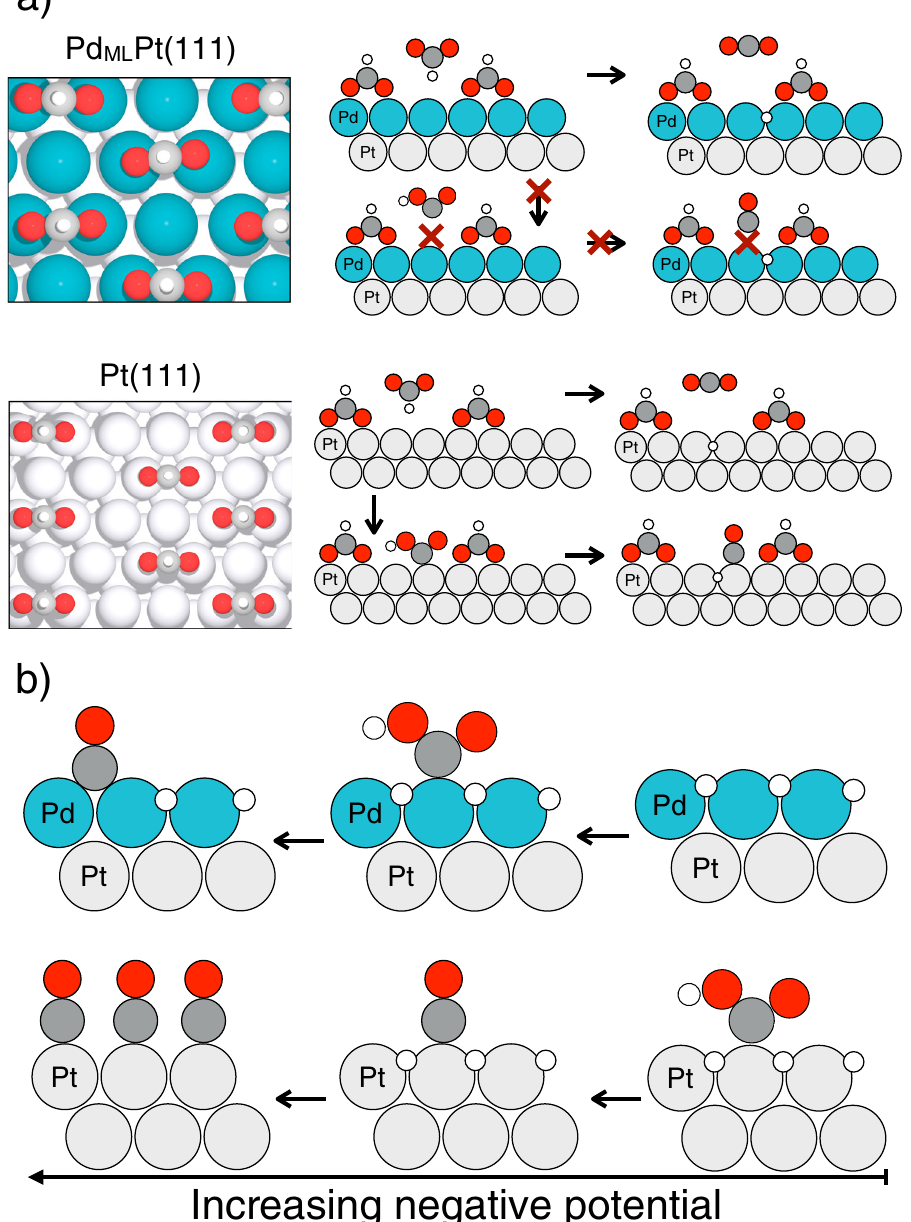
Fig. 6 Illustration of the model mechanisms. a For the CO poisoning pathway during formic acid oxidation on Pd ML Pt(111) (upper drawing) and Pt(111) (lower drawing) with top views of the surfaces on the left and side views on the right. During formic acid oxidation the formate coverage on Pd ML Pt(111) is 1/3 ML, and on Pt(111) is 1/4 ML. On Pt(111) the necessary two neighboring surface atoms for *CO formation from *COOH are available, while on Pd ML Pt(111) they are not available. b For the CO poisoning pathway during CO 2 reduction reaction, on Pd ML Pt(111) (upper sketch) and Pt(111) (lower sketch). Note that *COOH is adsorbed on Pt(111) at a less negative potential than on Pd ML Pt(111). Oxygen is in red, carbon in gray, hydrogen in